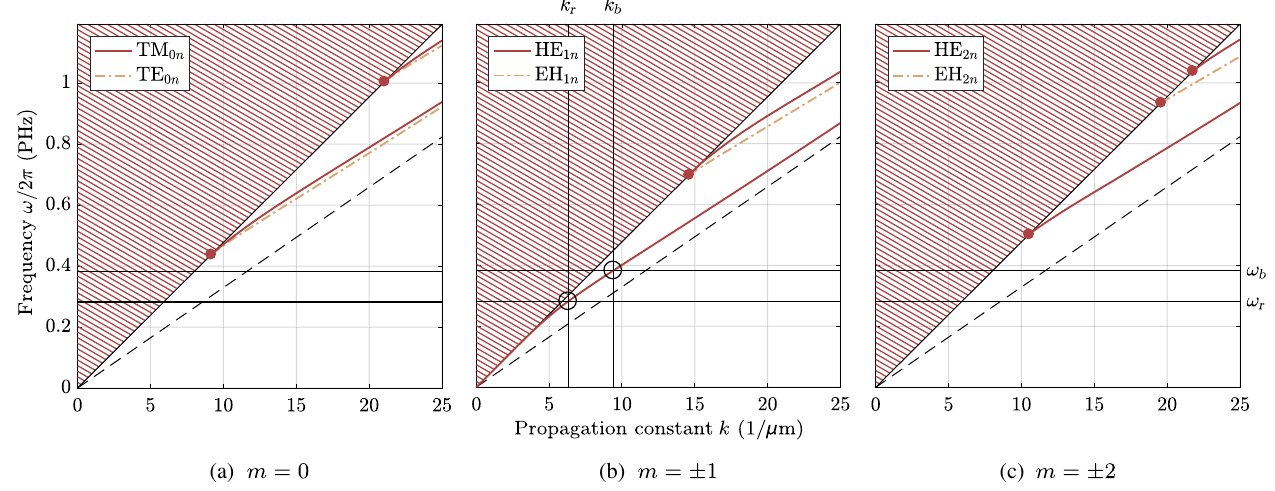
FIG. 3. Band structures of nanofiber photon modes with azimuthal order m ¼ 0 in panel (a), m ¼ (cid:4) 1 in panel (b), and m ¼ (cid:4) 2 in panel (c). The radius R and the relative permittivity ϵ are specified in Appendix E. The hatched area corresponds to radiative modes delimited by the vacuum light line. The dashed line delineates the dielectric light line. The cutoff frequencies, where guided bands cross over into the radiative continuum, are indicated by solid points. The modes populated in the case study in Sec. III are indicated by circles: Their frequencies ω , ω lie below all cutoff frequencies, so only modes on the fundamental HE 11 band can be r b